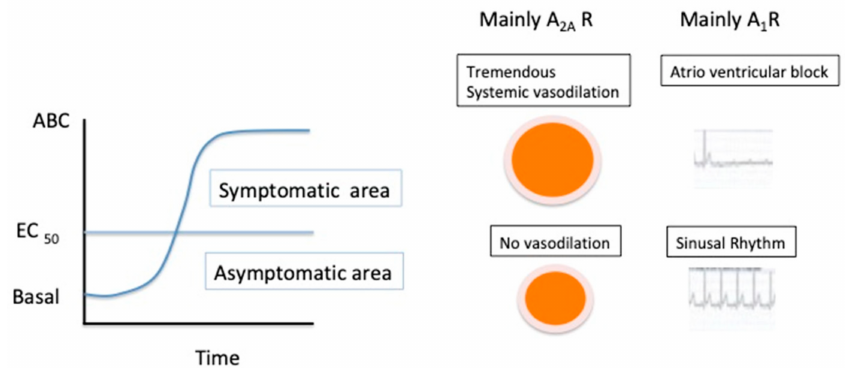
Figure 3. Effects of an increasing adenosine blood concentration (ABC) on the cardiovascular system in patients with neurohumoral syncope associated with low adenosine plasma concentration and spare adenosine receptors.